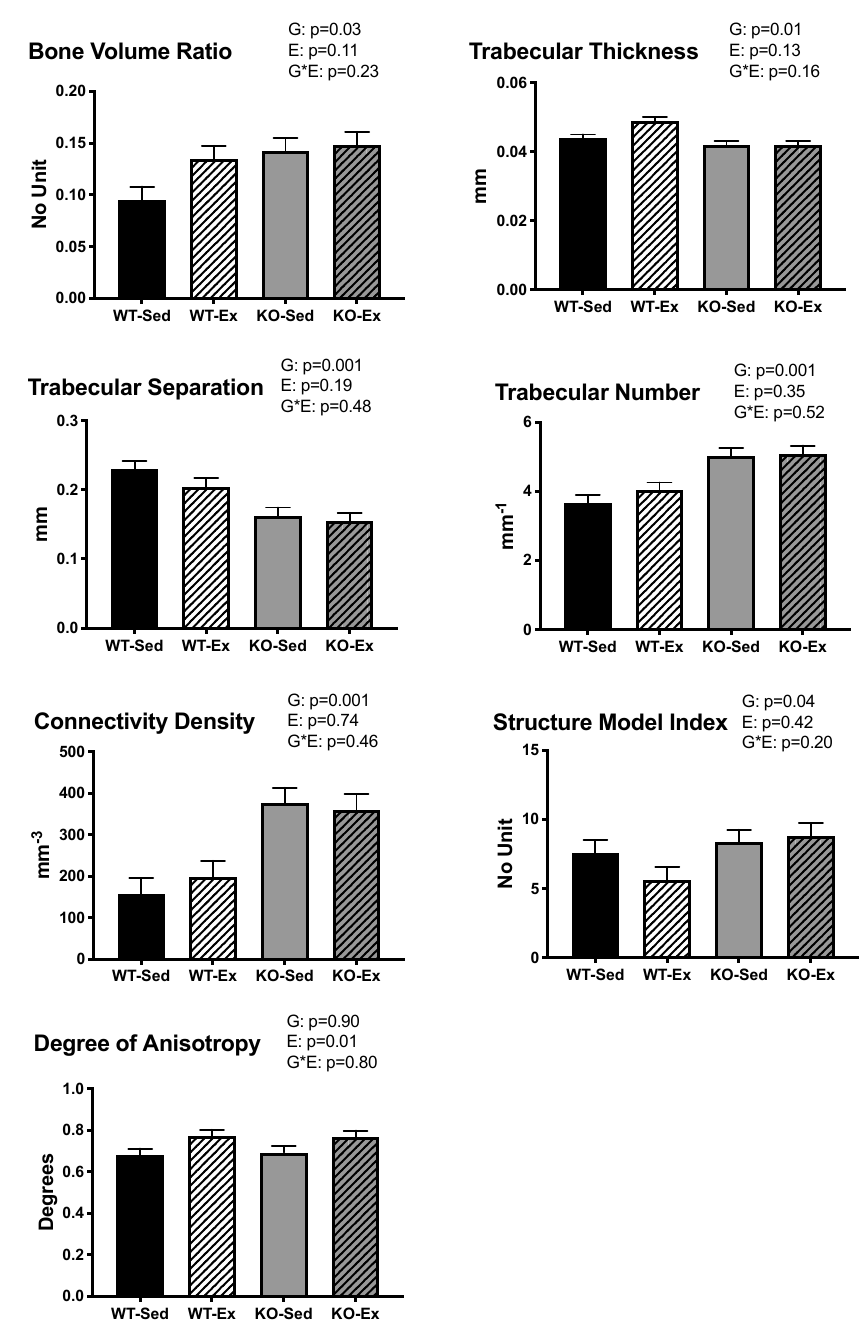
Figure 3. Tibial trabecular microarchitecture. Trabecular microarchitecture of the tibia. Data are means ± SEM, n = 6–8 per group ERKO: ER α knock out; WT: wild type; Ex: voluntary wheel running; Sed: sedentary. G: main effect of genotype ( p ≤ 0.05); EX: main effect of exercise status ( p ≤